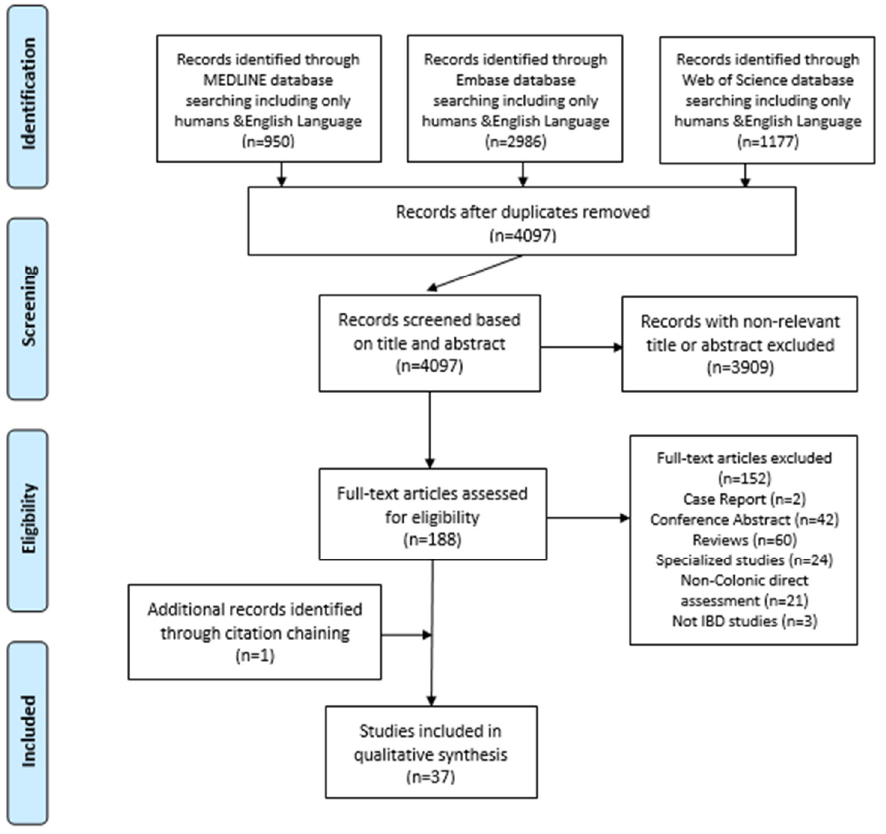
Figure 1. Flow diagram of the systematic review search. Adapted from Moher et al. (2009) and preferred reporting items for systematic reviews and meta-analyses (PRISMA) [10].